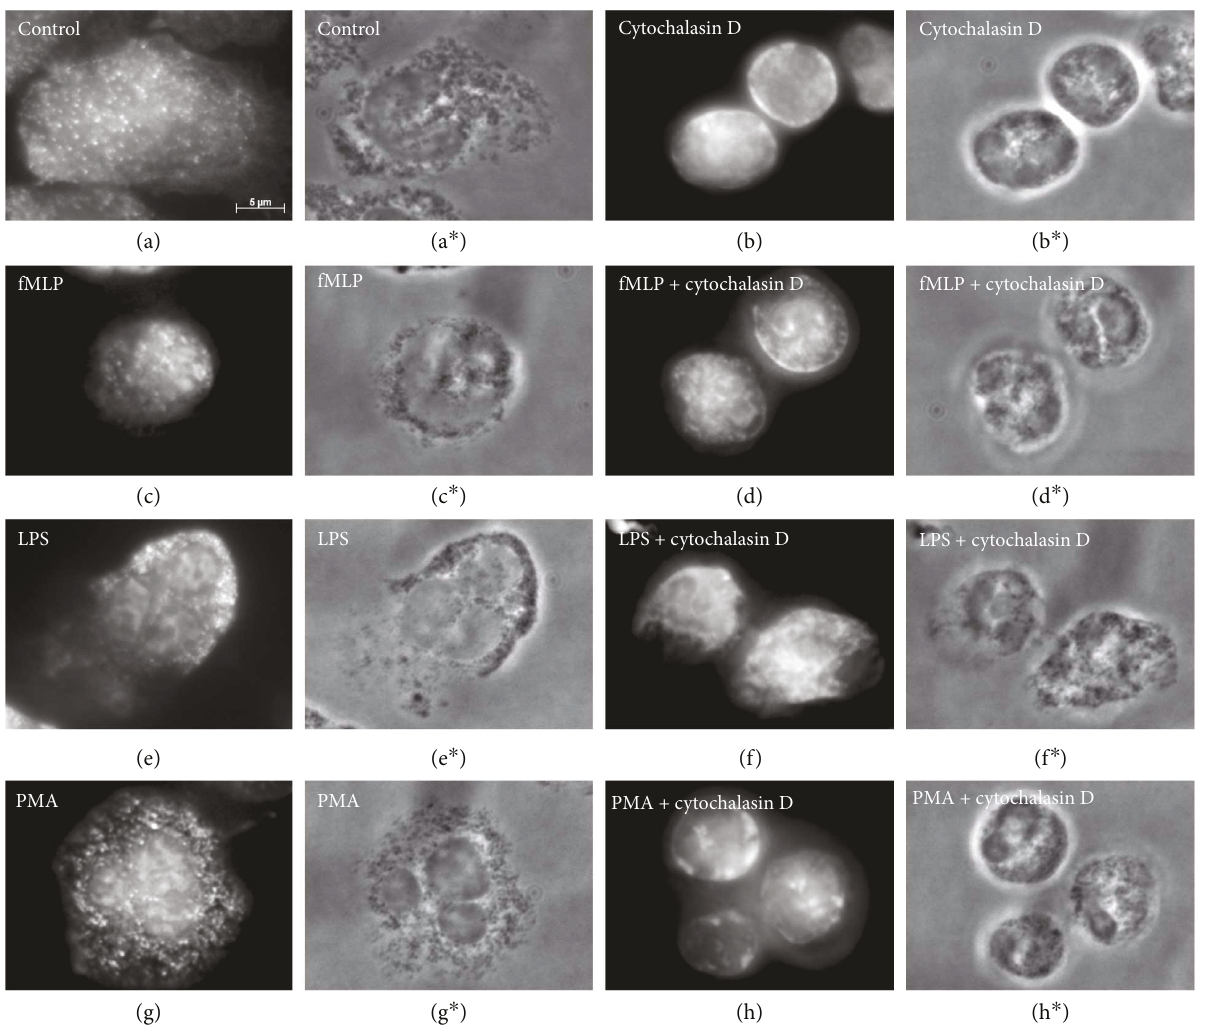
Figure 5: Fluorescentstainingofactincytoskeletoninneutrophilsthatwereattachedto fi bronectinundervariousconditions.Fluorescent(a – h) and phase-contrast (a ∗ – h ∗ , resp.) images of cells that were attached to fi bronectin-coated substrata under the control conditions (a) or in the presence of 1 μ M fMLP (c), 20 μ M LPS (e), or 0,1 μ M PMA (g), taken separately or in combination with 10 μ M cytochalasin D (b, d, f, h, resp.) for 20 min at 37 ° C. Neutrophils were stained for actin with FITC phalloidin. Pictures represent typical images observed in two independent